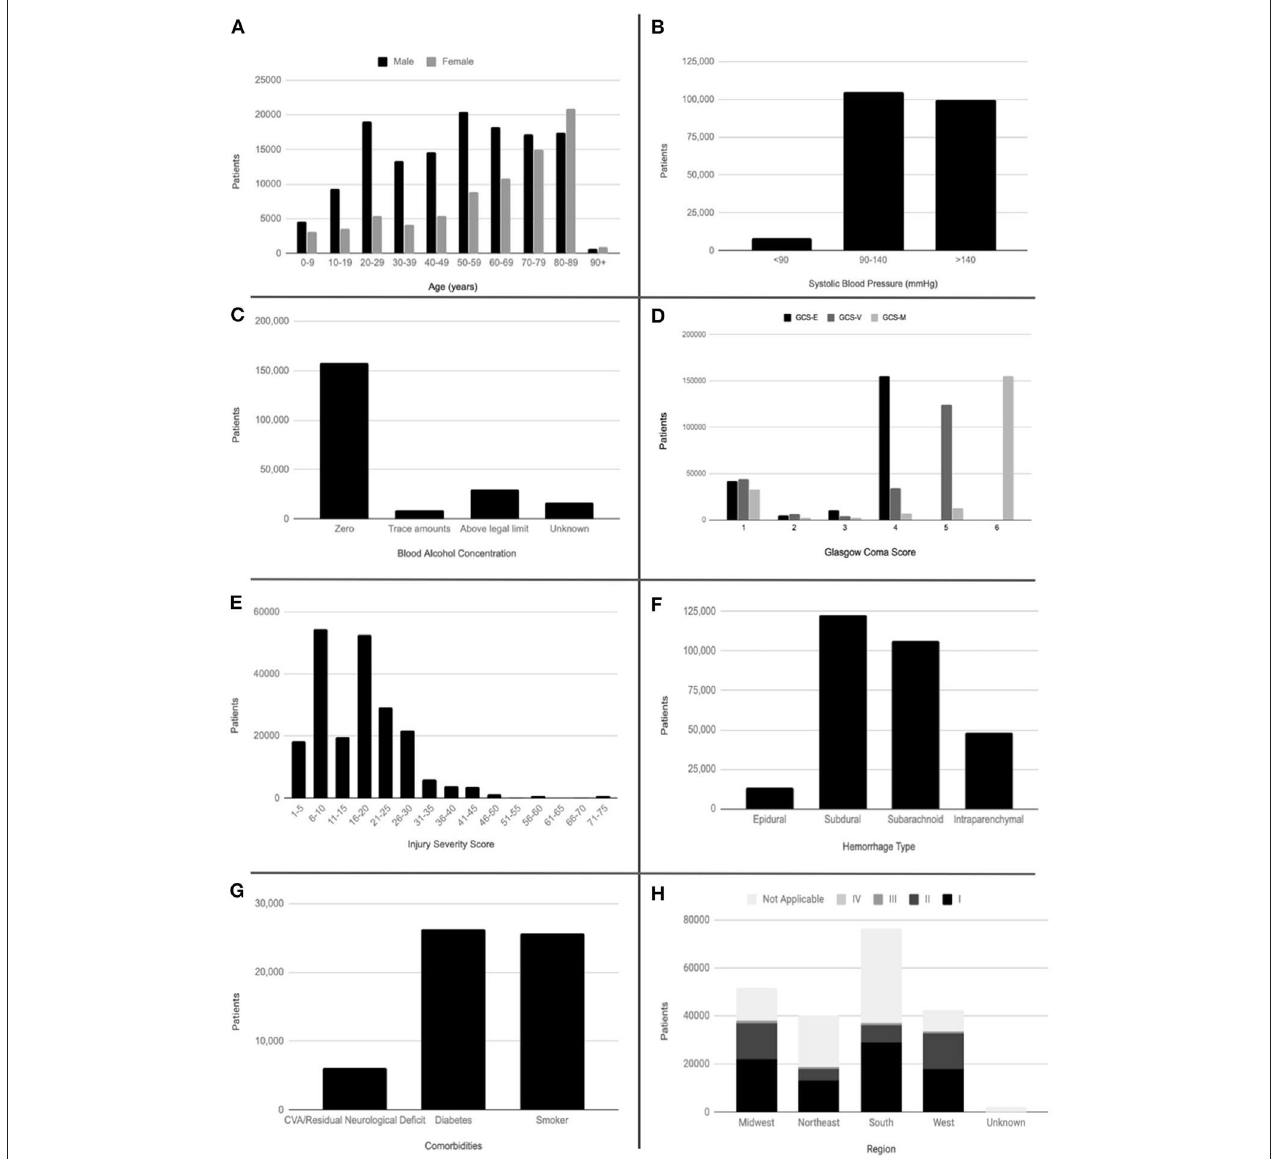
FIGURE 1 | Histograms of demographic and clinical data. (A) Patient age by sex. (B) Systolic blood pressure. (C) Blood alcohol concentration. (D) Glasgow Coma Subscores. (E) Injury Severity Score. (F) Hemorrhage type. (G) Comorbidities. (H) Trauma center level by region. CVA, cerebral vascular accident; GCS-E, Glasgow Coma Score–Eye; GCS-V, Glasgow Coma Score–Verbal; GCS-M, Glasgow Coma